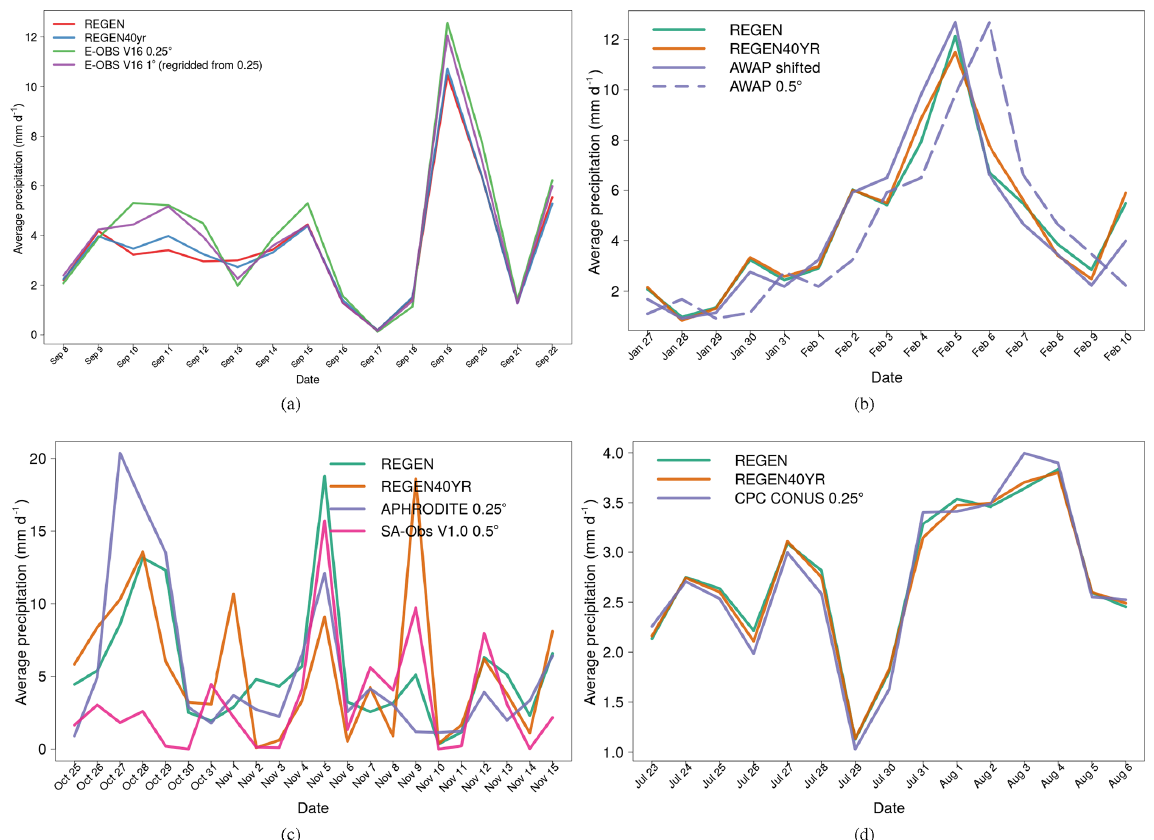
Figure 7. Daily time series averaged over spatial regions of significant rainfall events. (a) Time series of daily rainfall during the great flood of 1968 over southeast England. (b) Time series of daily rainfall during Cyclone Yasi in northeast Australia in 2011. (c) Time series of daily rainfall during typhoon Thelma in Philippines in 1991. (d) Time series of daily rainfall during Tropical Storm Amelia in the USA in